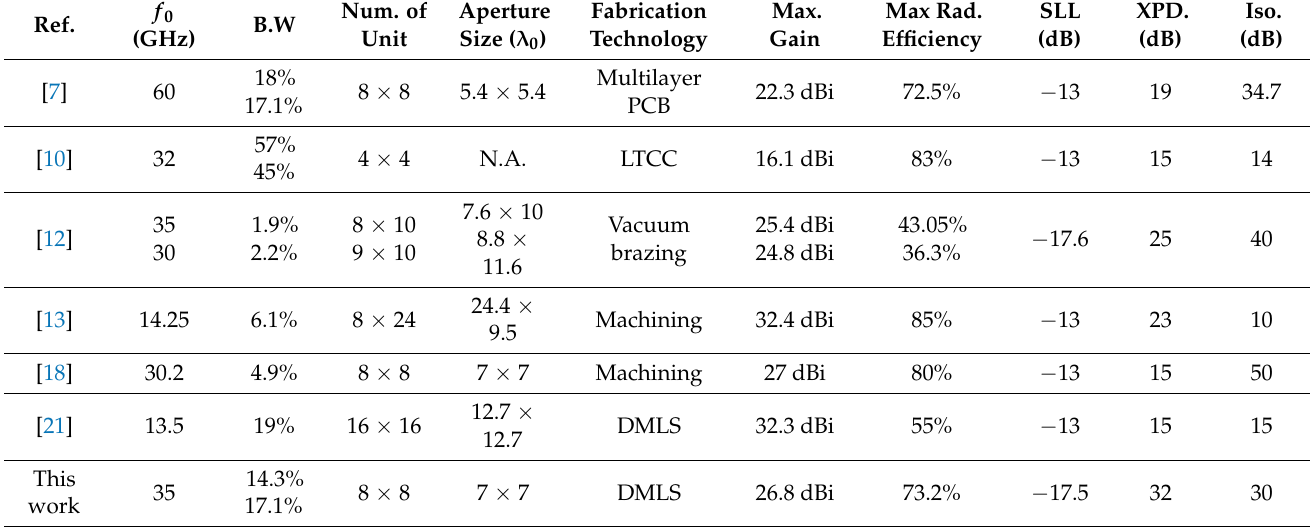
Table 2. Performance comparison of the presented planar dual-polarization antenna arrays (unit: mm). Ref.